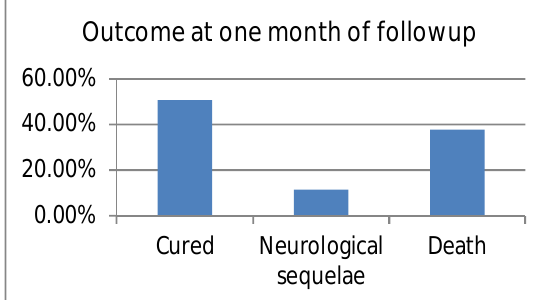
Figure 1: Outcome at 1 month of follow up